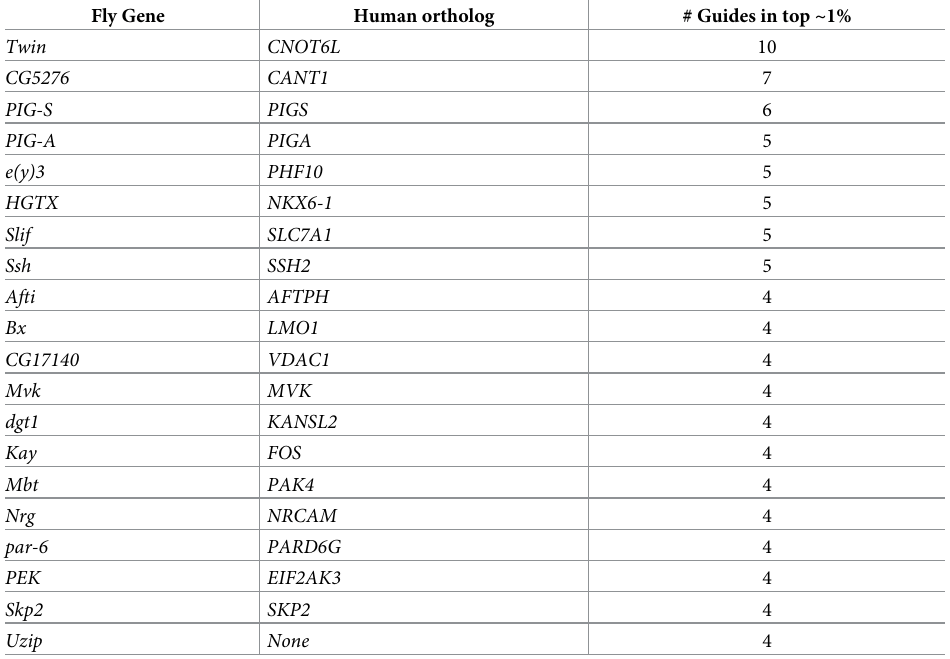
Matching the strong effect that we observed in the survival screen, RNAi against either of these two enzymes improved the DPAGT1 model ( Pfk : +32.2%, Pfrx : +11.3%, averaged across two biological replicates). On the other hand, in the nucleotide sugar synthesis pathway, RNAi against transaminase-encoding Gfat2 , despite causing resistance (lfc = 4.68), did not signifi- cantly affect the DPAGT1 model (S7 Table). Moreover, RNAi against the deaminase-encoding Oscillin , which caused sensitivity (lfc = -1.87), improved the DPAGT1 model (+28.8%). These differences from the cell screen may be caused by the differing biology of simple replicating cells compared to an in vivo eye model which has to pass through multiple stages of develop- ment and differentiation.